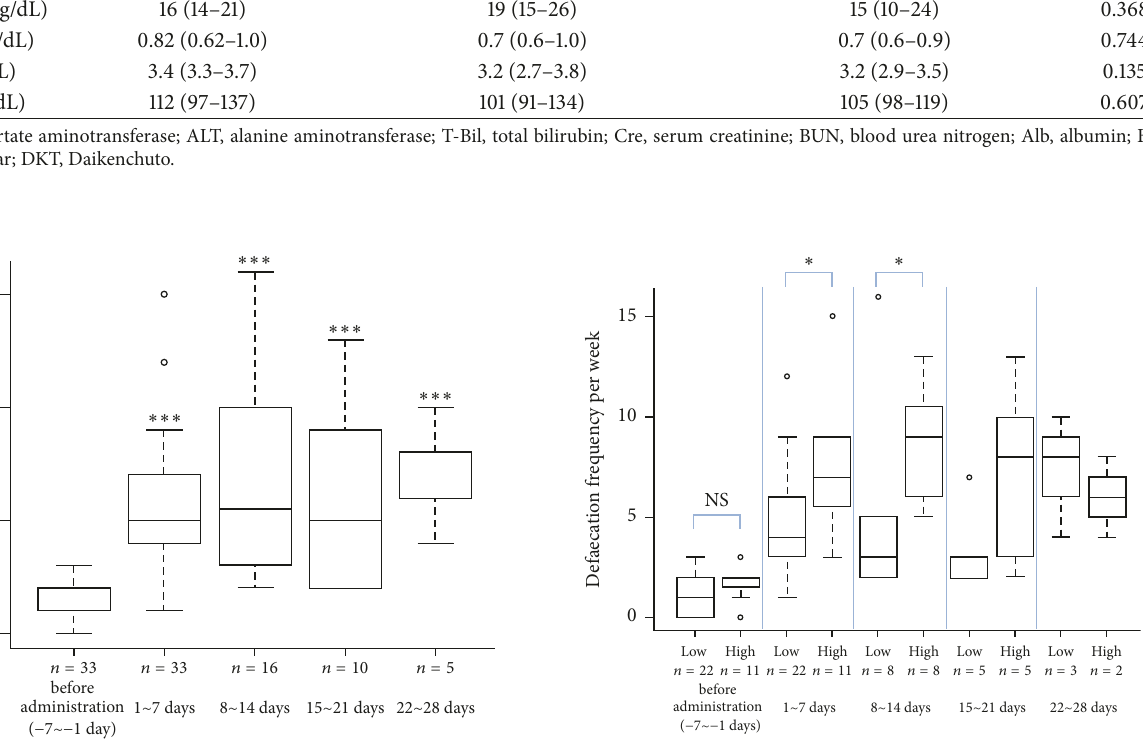
Figure 2: Defaecation frequency per week was compared between the high- and low-dose groups at each week. ∗ indicates significance compared to values between the high- and low-dose groups. NS, not